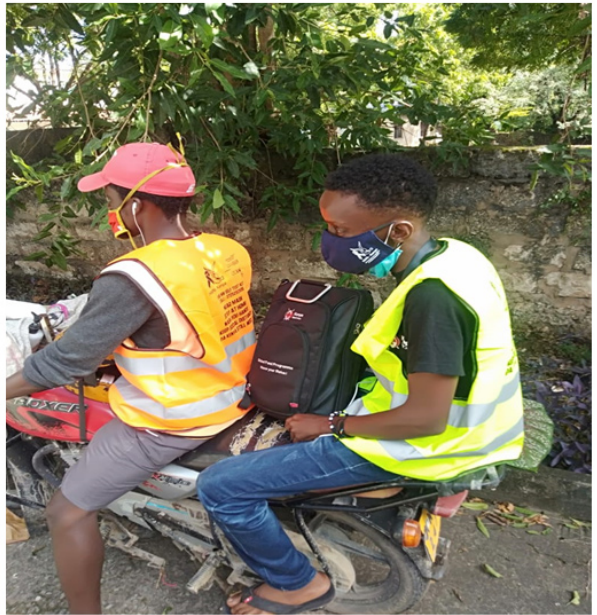
Figure 9. Peer educator from HAPA delivering commodities to clients on a motorbike.